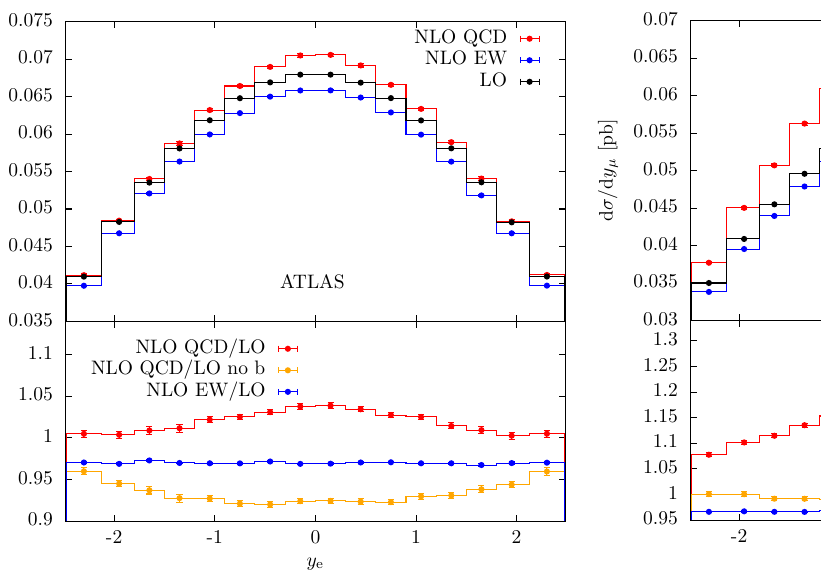
Fig. 6 Differential distribution in the positron and muon rapidities ( y e and y μ , respectively) for the process pp → e + ν e μ − ¯ ν μ at under the event selections of Eqs. (4.4) and (4.5). Same notations and